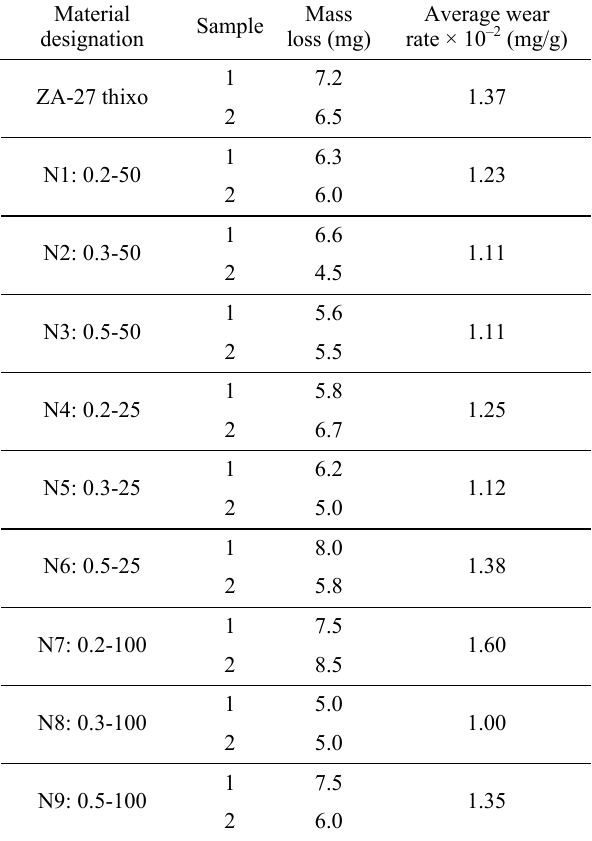
Table 4 Mass loss and calculated average wear rate of tested materials.